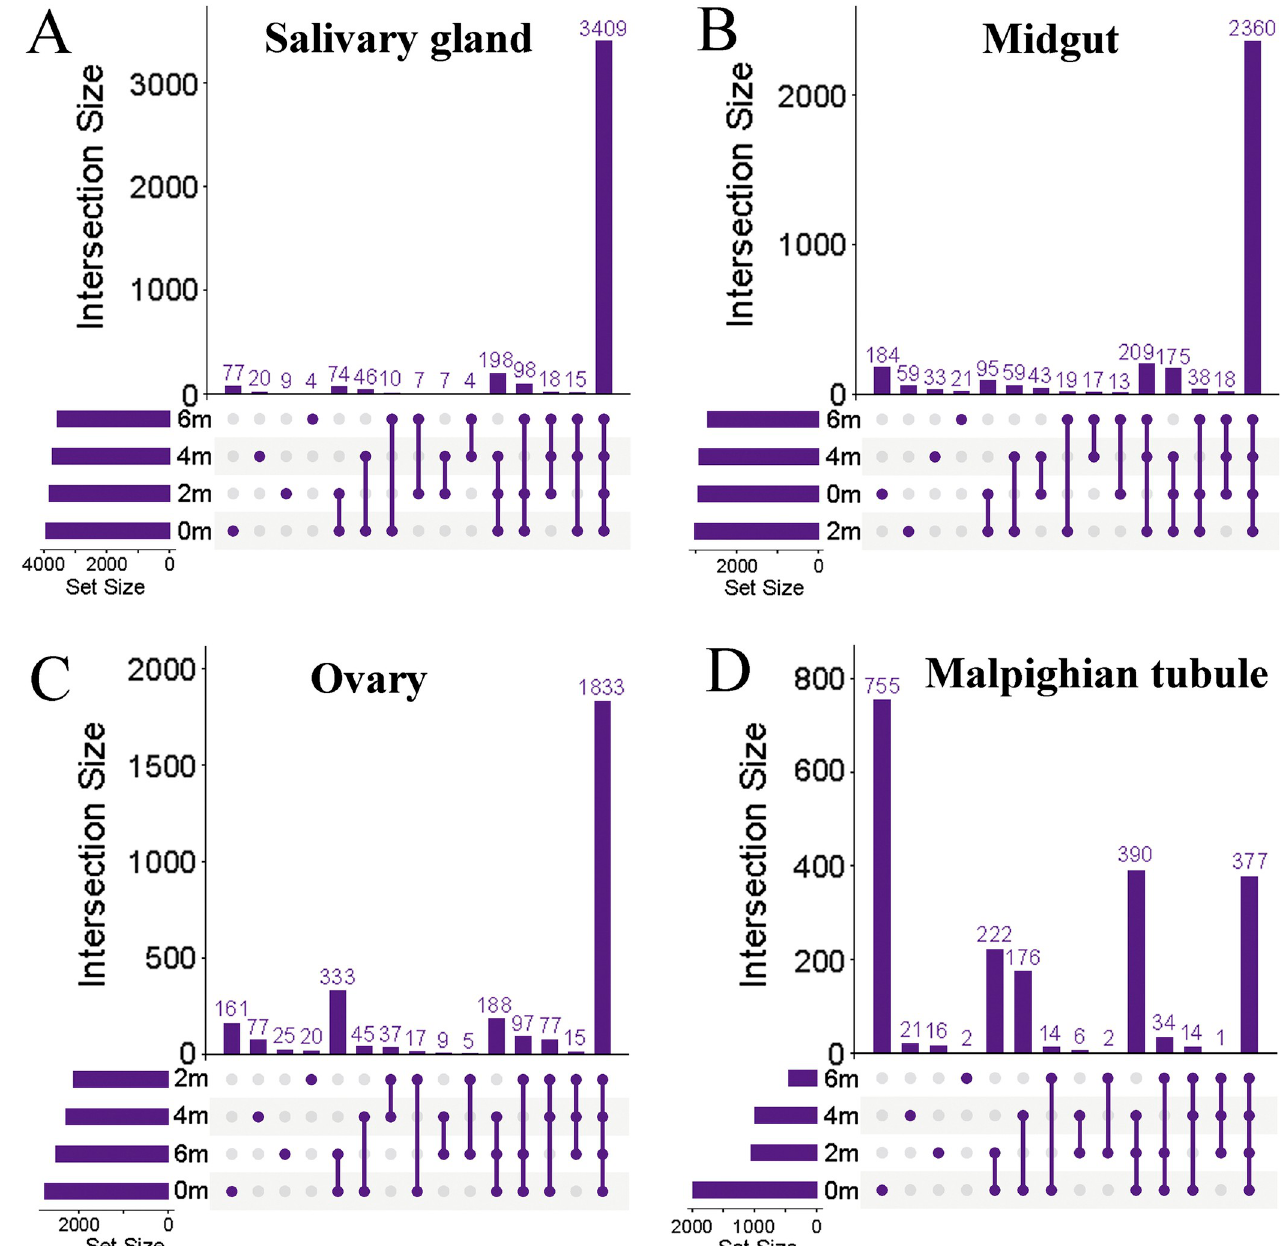
Fig 1. Analysis of four tissue intersection proteins at different stages of starvation of female H . longicornis . The dot represents the individual proteins in the four periods, the dot and the connecting line represent the intersection proteins in different periods, and the bar graph corresponding to it on the top represents the number of proteins. A. Salivary glands, B. Midguts, C. Ovaries, D. Malpighian tubules. m: month.